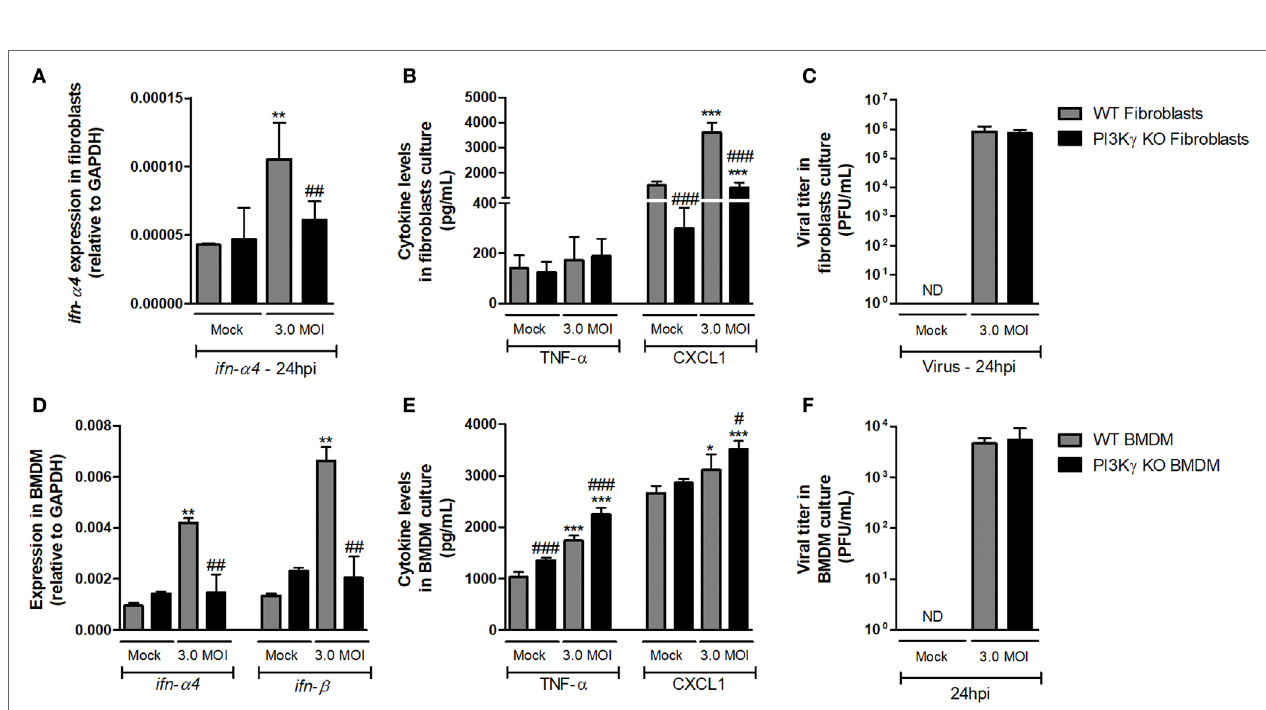
FigUre 5 | Altered antiviral responses in the absence of phosphatidyl inositol 3 kinase-gamma (PI3K γ ) in leukocytes and resident cells. Lung-derived fibroblasts from WT and PI3K γ knockout (KO) infected with influenza WSN [multiplicity of infection (MOI): 3.0] were evaluated after 24 h. mRNA levels of (a) ifn- α 4 , assessed by real-time PCR. In cell supernatants, (B) TNF- α and CXCL1 levels by ELISA and (c) viral titer in by plaque assay in Madin–Darby Canine Kidney cells. Bone marrow-derived macrophages (BMDM) from WT and PI3K γ KO were infected with influenza WSN (MOI: 3.0). 24 h after infection, (D) ifn- α 4 and ifn- β expression, (e) TNF- α and CXCL1 levels, and (F) viral titer were assessed as for fibroblasts. Results are presented as mean ± SD. * p < 0.05, ** p < 0.01, and *** p < 0.001, when compared with each Mock group; # p < 0.05, ## p < 0.01, and ### p < 0.001, comparing PI3K γ KO to WT-infected cells (one-way ANOVA,